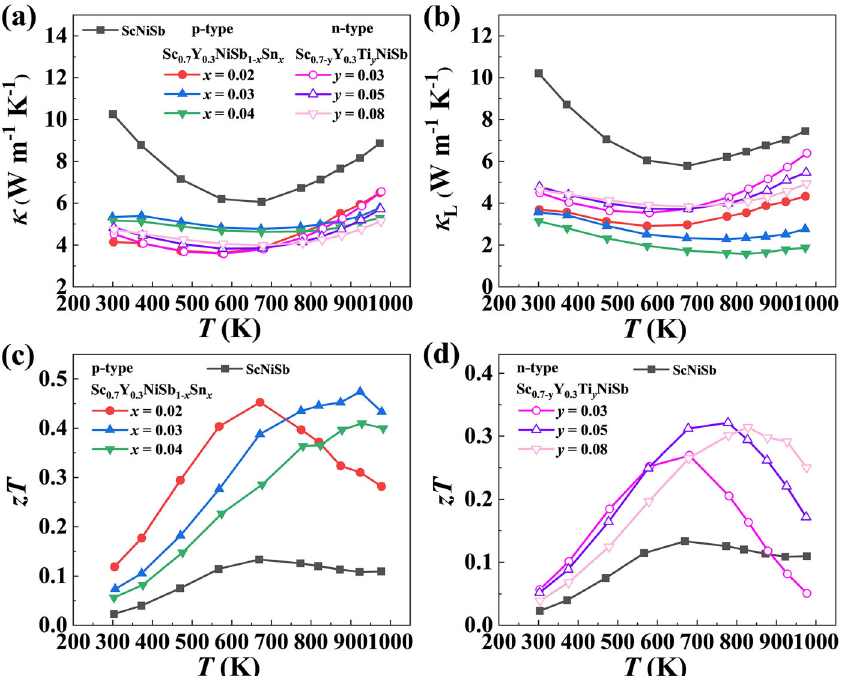
Fig. 7 Temperature-dependent thermal performance and zT values of ScNiSb, Sc 0.7 Y 0.3 NiSb 1 − x Sn x ( x = 0.02, 0.03, and 0.04) and Sc 0.7 − y Y 0.3 Ti y NiSb ( y = 0.03, 0.05, and 0.08). a Thermal conductivity. b Lattice thermal conductivity. c, d zT